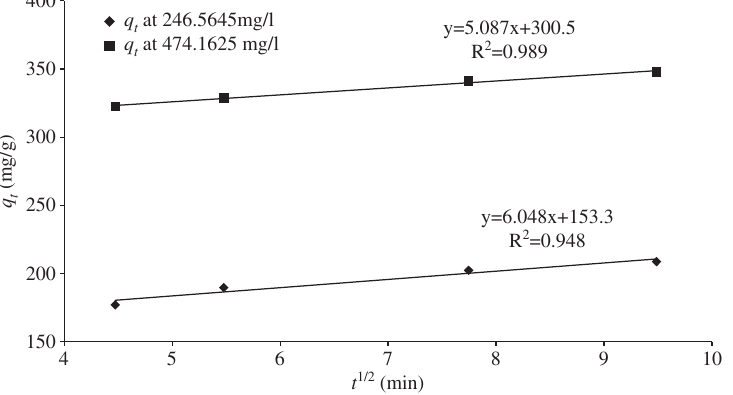
Figure 9: Test of intra-particle diffusion of Pb(II) onto Sesbania sesban L at concentrations of 246.5645 and 474.1625